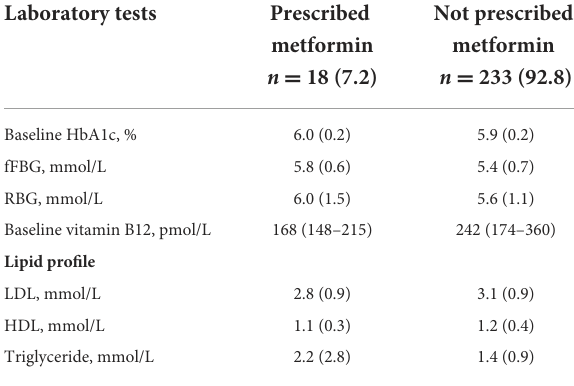
TABLE 4 Patients’ baseline laboratory data based on the prescribing of metformin.